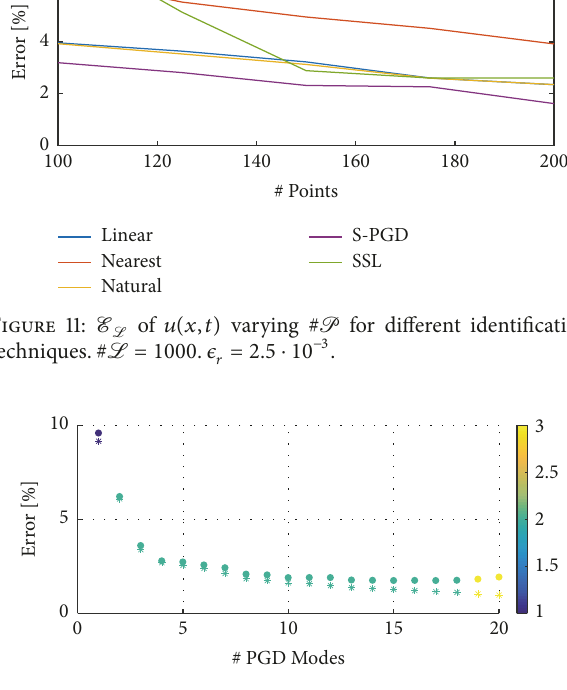
sPGD (PGD points) sPGD (All points) Figure 12: E L (points) and E P (asterisk) versus the number of modes for 𝑓 3 (𝑥 1 , 𝑥 2 , .. ., 𝑥 𝑁 ) , # P = 500 , # L = 3000 . Modal adaptivity based on the residual, 𝜖 𝑟 = 1𝑒 − 3